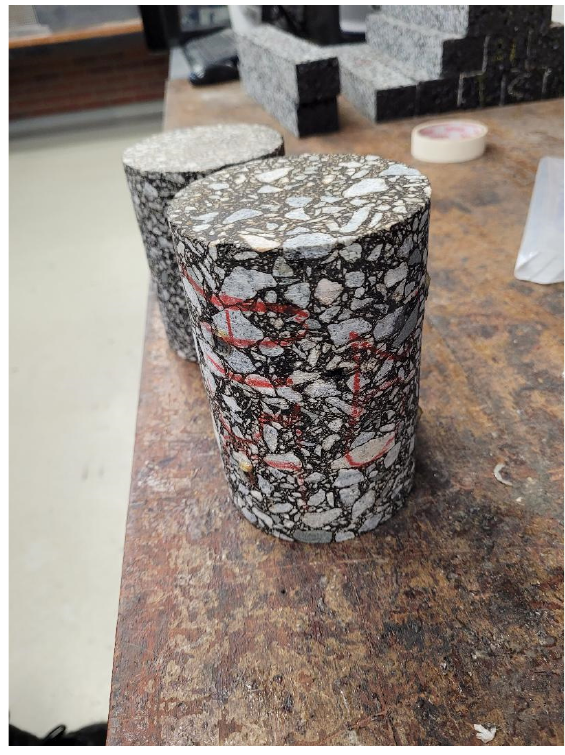
Figure 10. AMPT test sample.